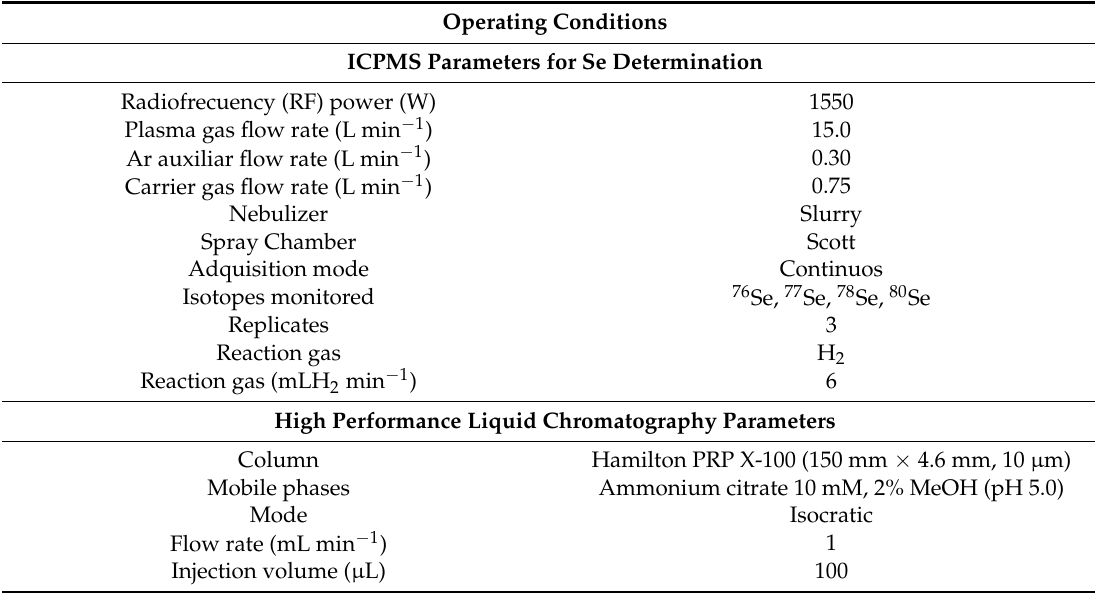
Table 1. Operating conditions for high performance liquid chromatography (HPLC) coupled to inductively coupled plasma-mass spectrometry